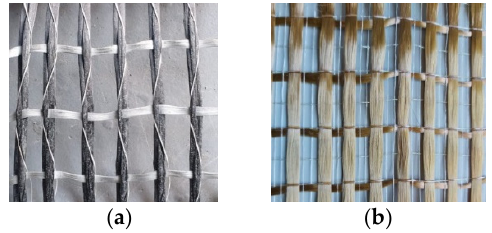
Figure 3. Fabric types: ( a ) carbon fabric; ( b ) PBO fabric. Table 2. Fabric properties provided by the manufacturer [34,35].